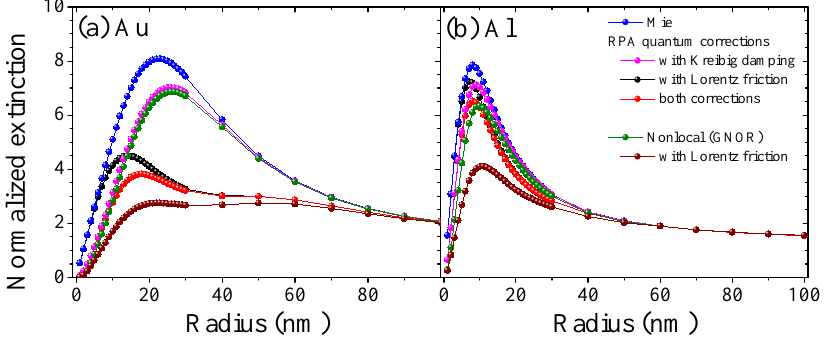
Figure 3. Extinction cross section normalized to the surface of a hemisphere for isolated ( a ) gold and ( b ) aluminum nanoparticles evaluated at the respective LSPR wavelengths from Figure